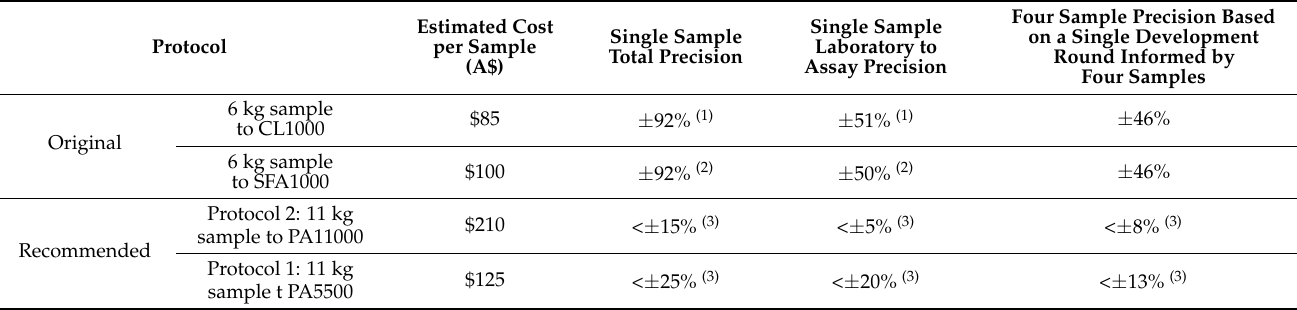
Table 26. Cost data (Australia, October 2021) for the original and revised protocols and associated sample data precision. Analysis based on LV samples